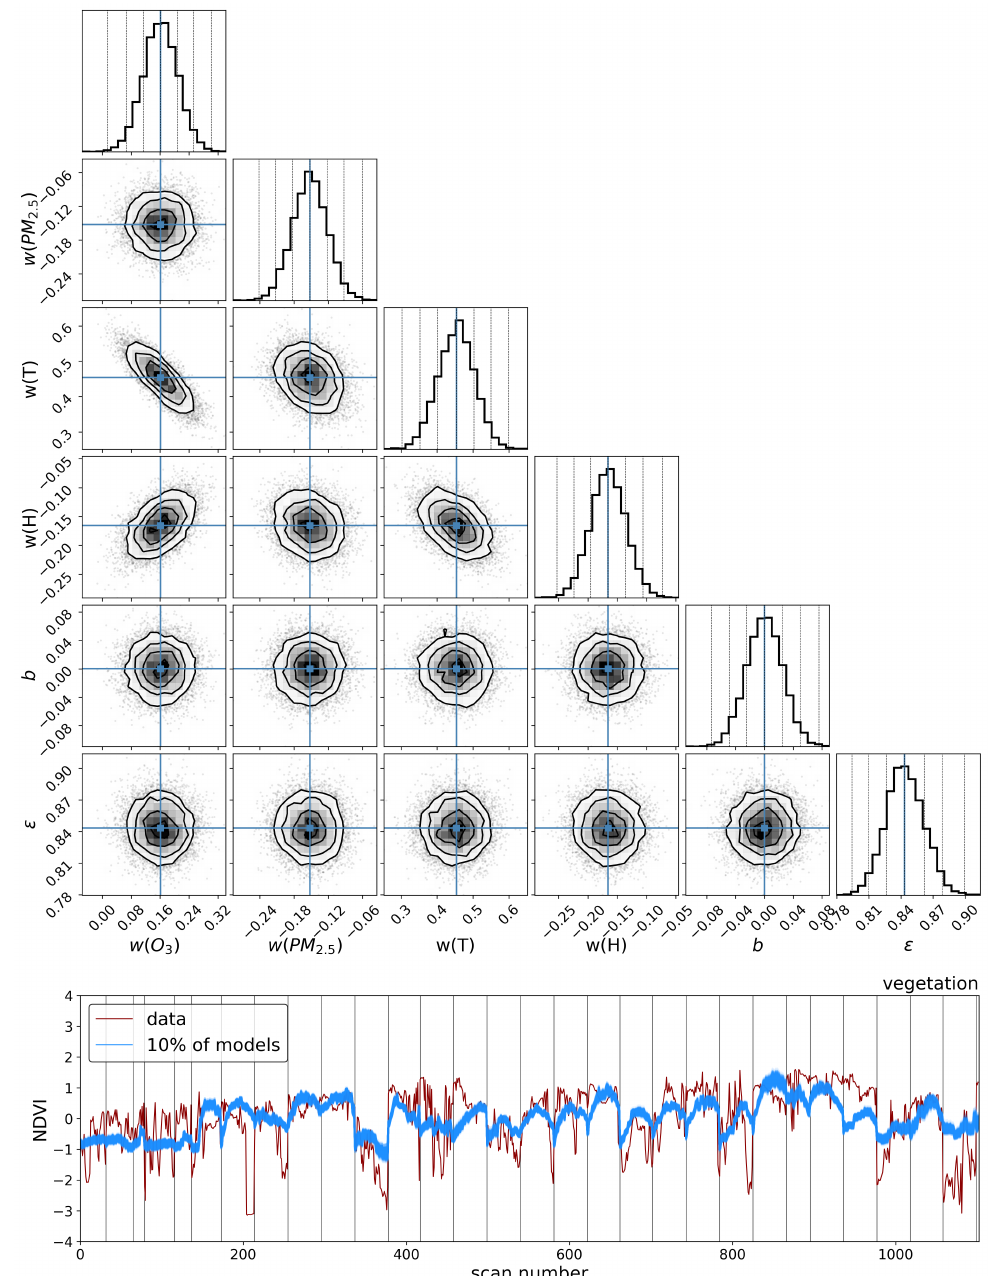
Figure A1. MCMC corner plot of posterior distribution for NDVI of vegetation. Consistent with the results obtained using SIF, r 2 using the NDVI for vegetation is significantly higher than for buildings, and all air quality coefficient parameters for the building model are consistent with zero to within uncertainty but not for vegetation. However, the r 2 obtained using the NDVI for vegetation (30%) is slightly lower than that obtained using SIF (40%) and component 4 of PCA